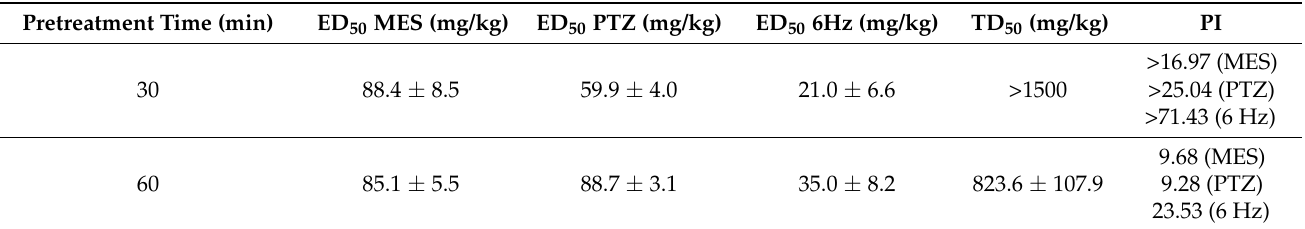
Table 1. Antiseizure and acute adverse effects of C-11 in the three seizure models and chimney test in mice. Pretreatment Time